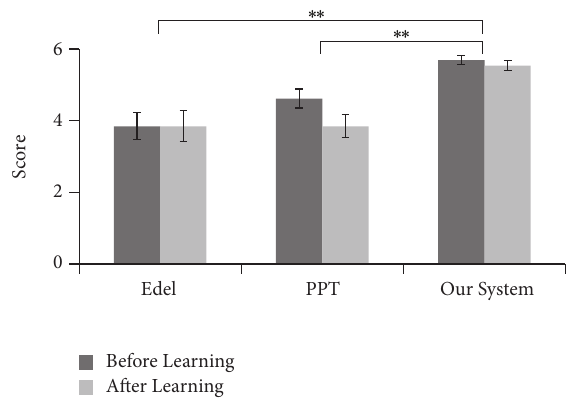
Figure 16: Results for Q4: the average and standard error for each system ( ∗∗ 𝑃 < 0.01 ).